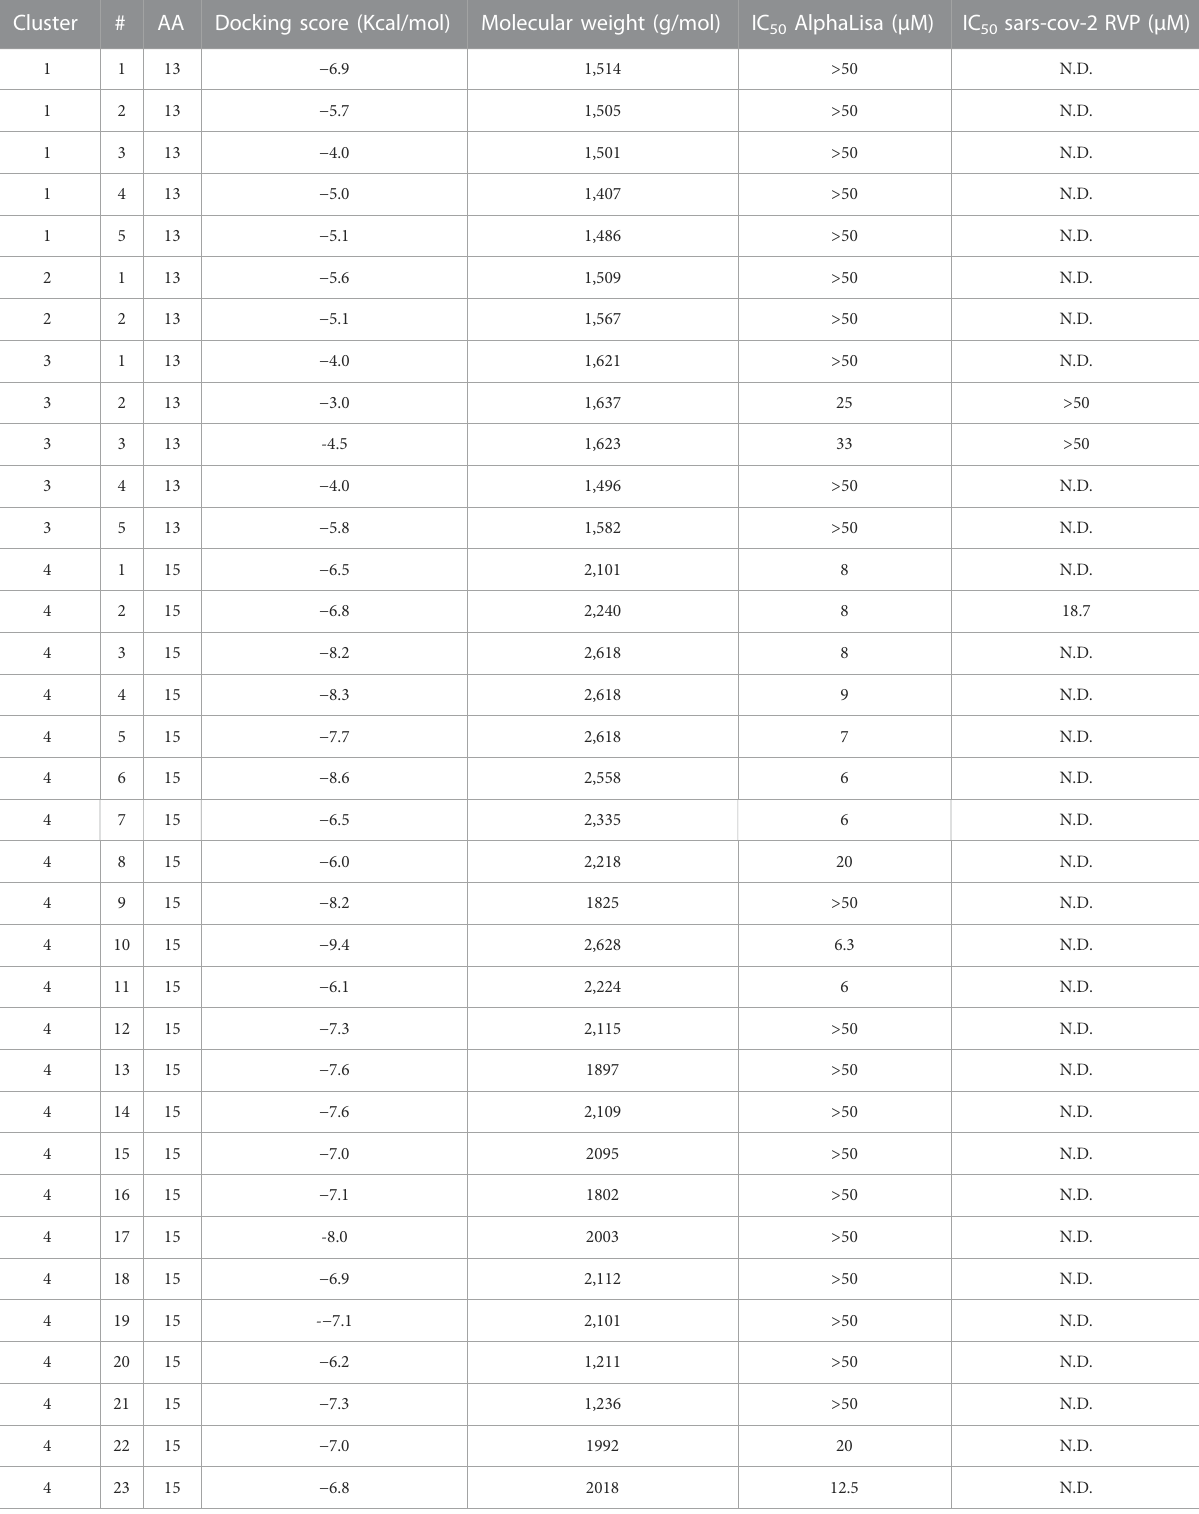
TABLE 3Peptidomimetics designed to targetspike at the ACE2 interface. Macrocycles representative of fi ve clusters were synthesized and screened for spike RBD/ACE2 complex formation inhibition using AlphaLISA. AlphaLISA IC 50 values are shown. Representative macrocycles showing inhibitory activity were selected for SARS-CoV-2 RVP inhibition assays. N.D. = Not Done. Values with a greater than ( > ) symbol indicate that IC 50 was not reached at maximal tested dosage.